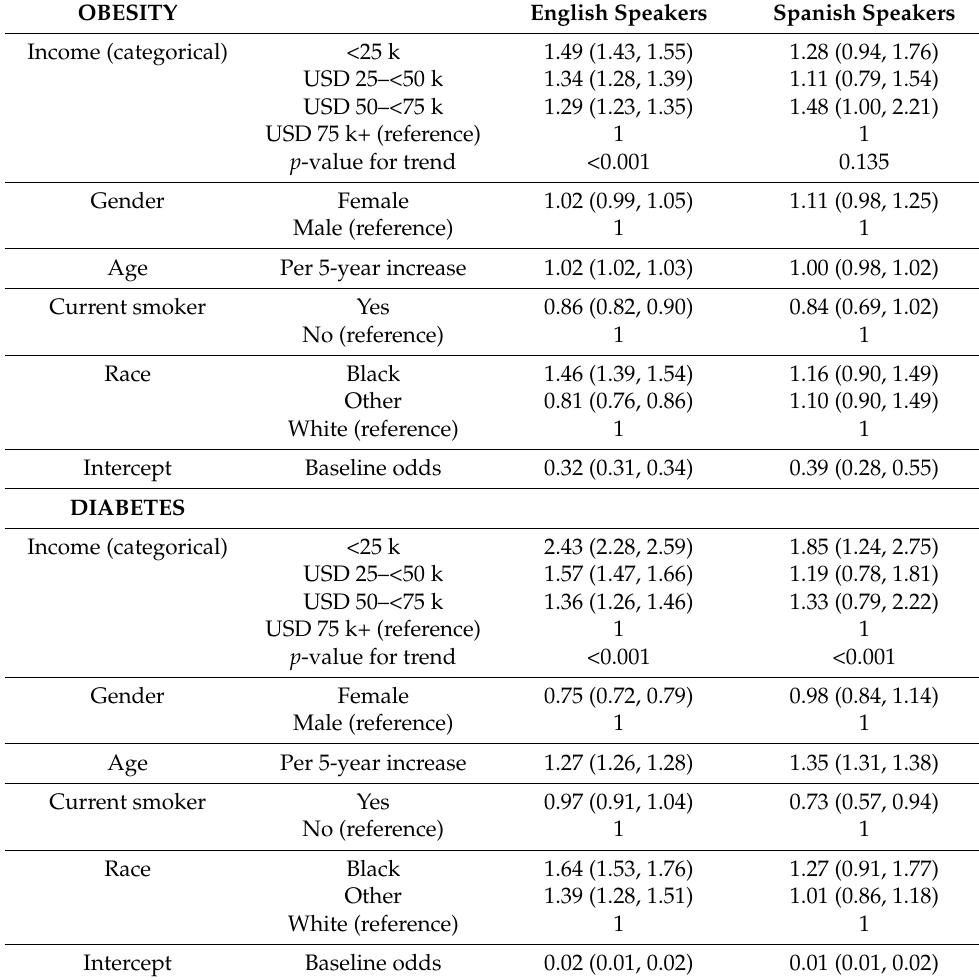
Table 3. Adjusted odds ratios of obesity (top) and diabetes (bottom) among English and Spanish speakers for individual